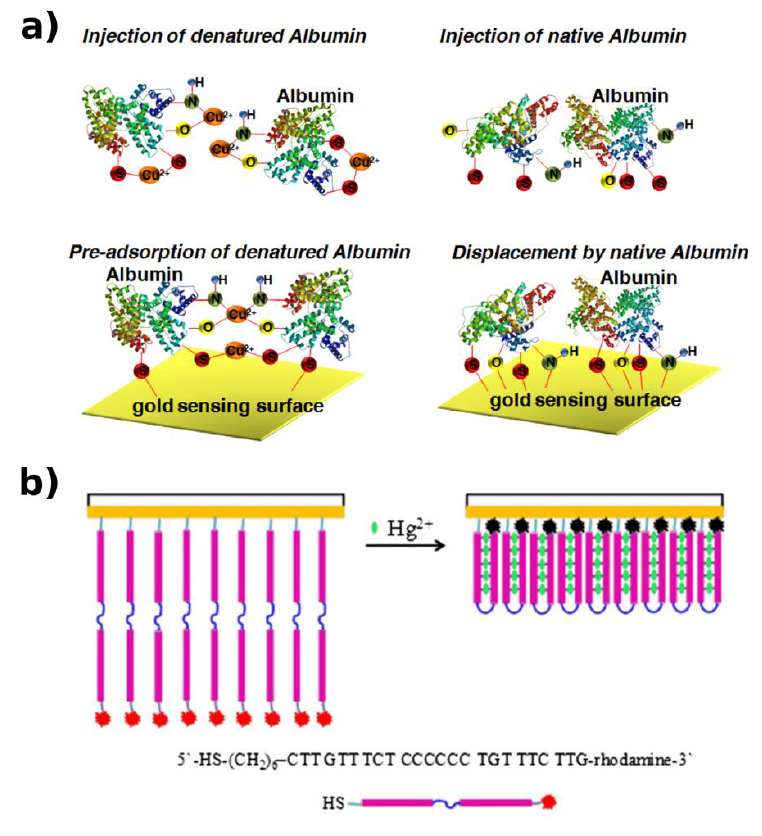
Figure 10. ( a ) Protein and DNA structure conformational changes, for SPR-based HM detection. The interaction between native proteins and Cu 2 + leads to the protein structure denaturation and weakens